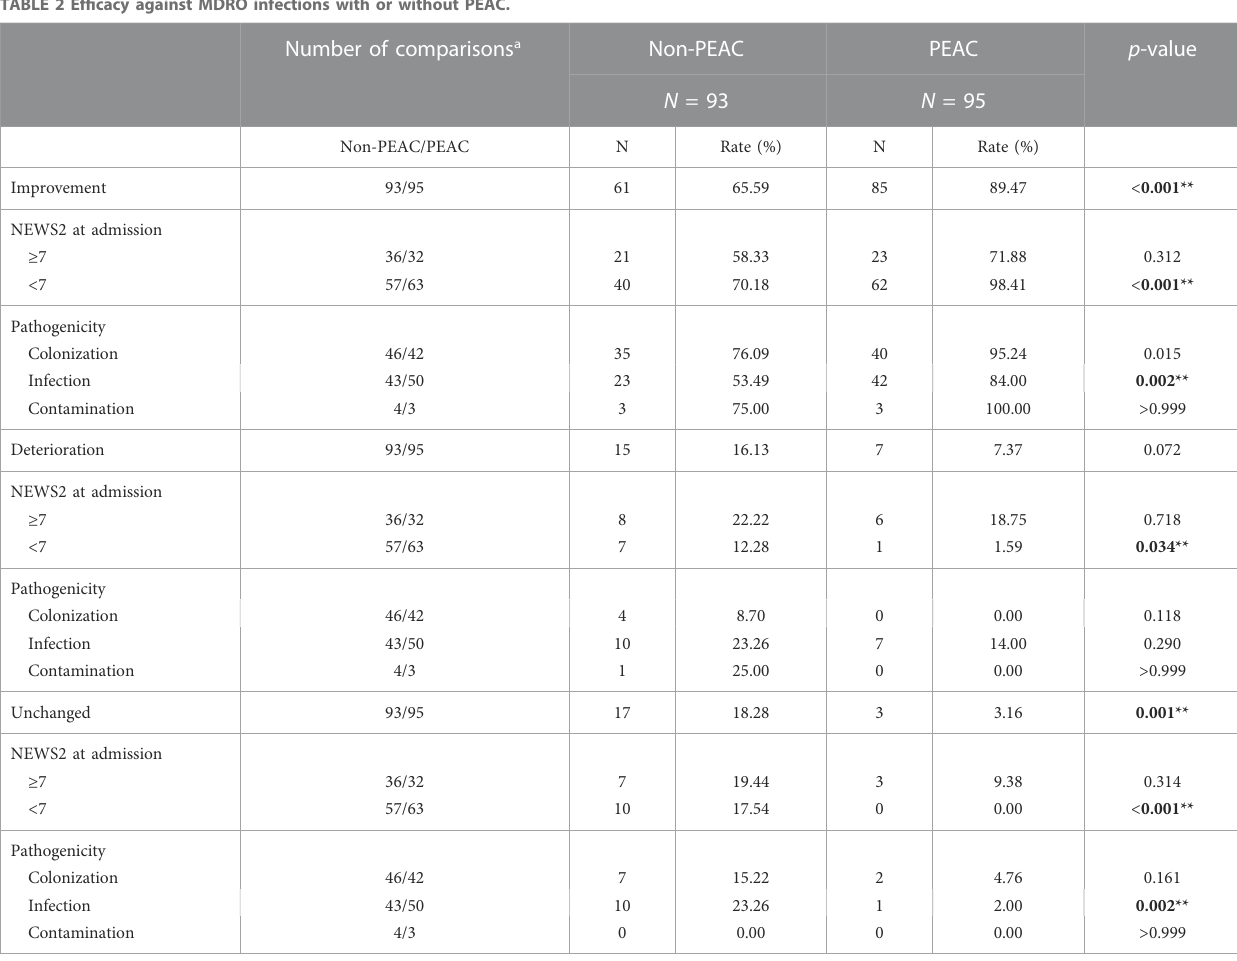
TABLE 2 Ef fi cacy against MDRO infections with or without